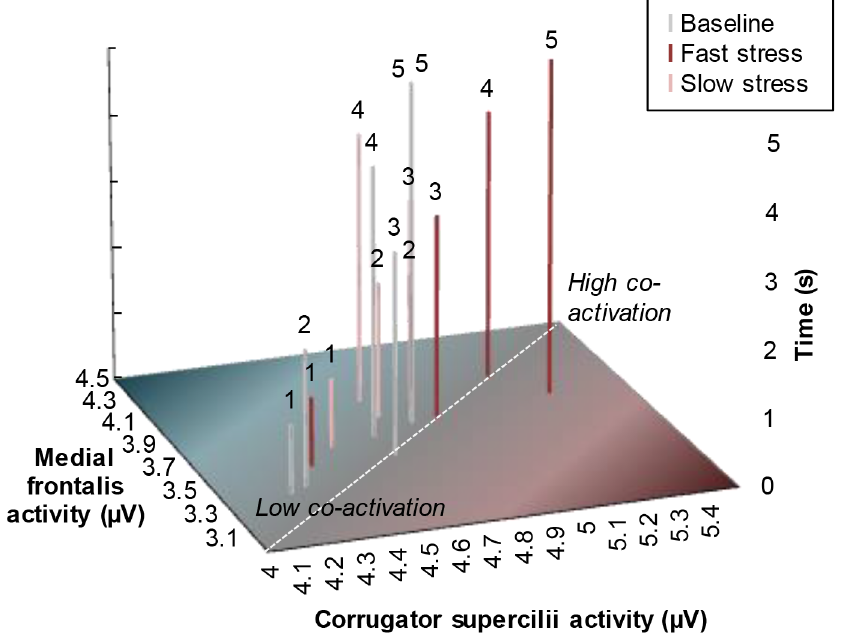
Fig 4. Mean facial muscle co-activation of receivers over time as a function of odor. Facial muscle activity displayed here was measured before the start of the facial expression classification task, to isolate the effect of odor. Above each bar, the time after odor onset (in seconds) is depicted (see Y-axis). The more each bar is located toward the upper-right end point (vs. bottom-left starting point) of the dashed diagonal, the more the medial frontalis and corrugator supercilii muscles co-activated ( μ V), resembling a fearful facial expression [cf. 11,